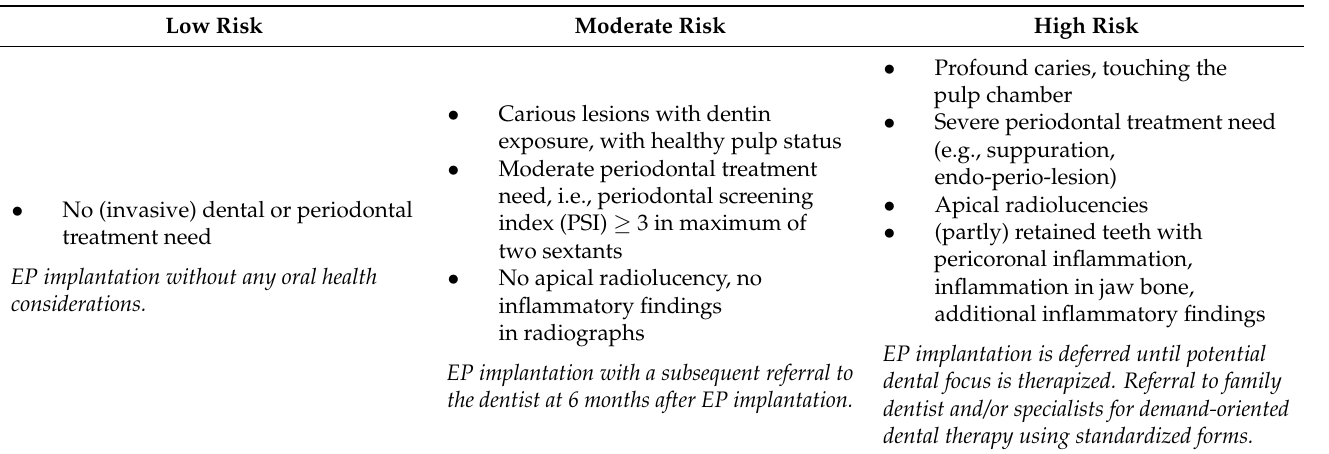
Table 1. Definition of the three risk groups for endoprosthesis (EP) infection with oral origin. Low Risk